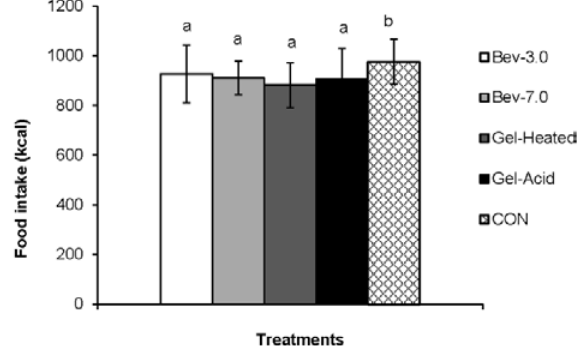
Figure 5. Mean energy intake at the ad libitum lunch for each snack. Different letters denote significance ( p < 0.05) between treatments. Snacks: 0 kcal water (CON) or 96 kcal whey protein snacks as beverages with a pH of either 3.0 (Bev-3.0) or 7.0 (Bev-7.0) or gels as acid (Gel-Acid) or heated (Gel-Heated).